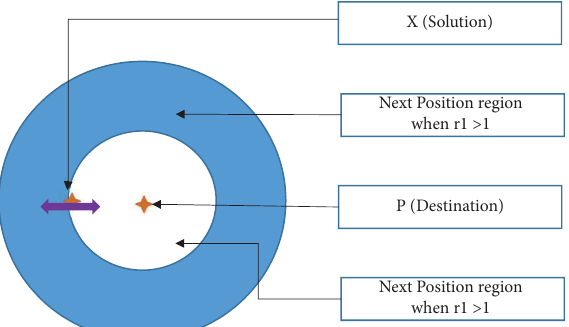
Figure 1: Efects of the sine and cosine function in updating the latest value [43].